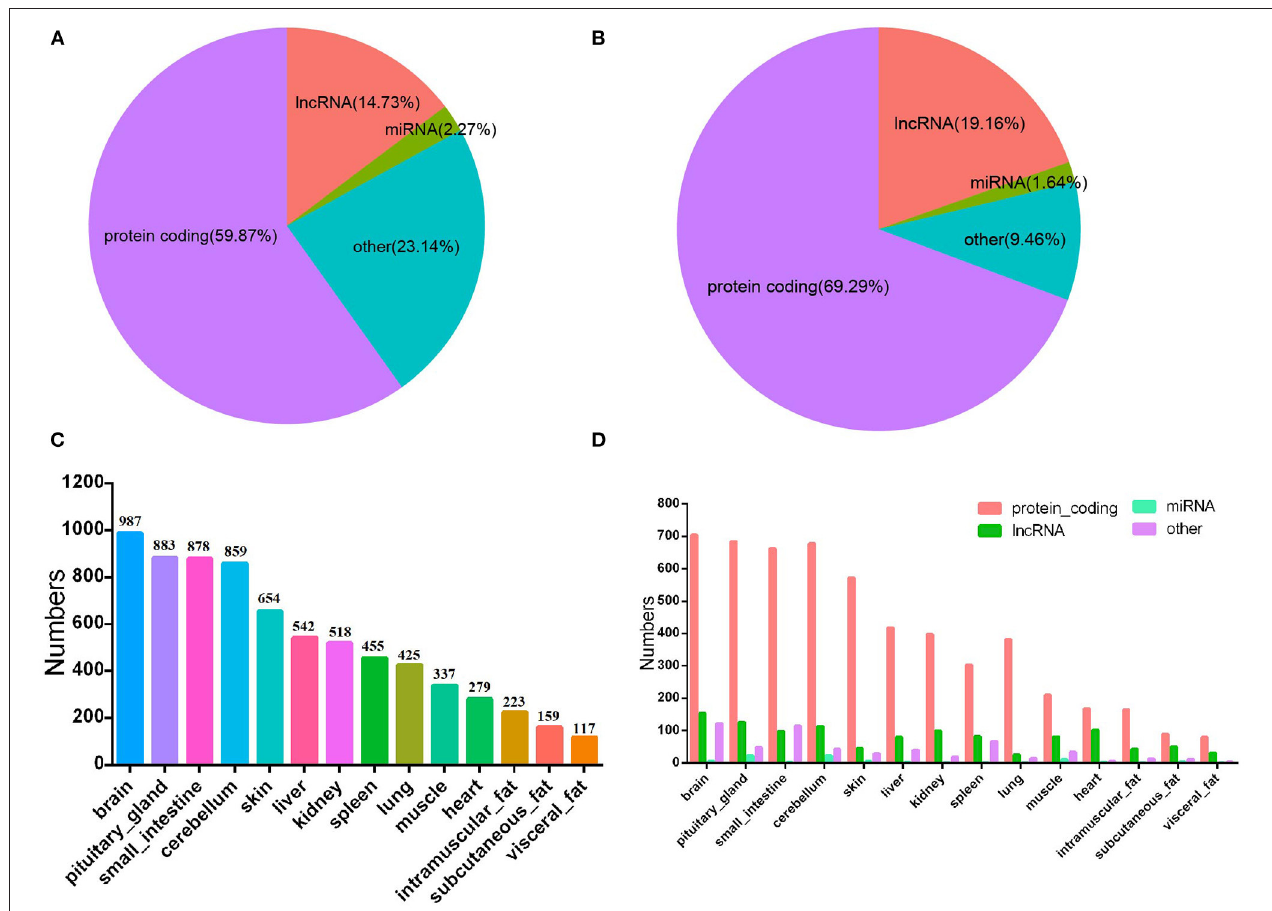
FIGURE 2 | Characteristics of bovine tissue-specific genes. (A) , The distribution of different kinds of RNA gene of bovine genome; (B) , bovine tissue-specific genes; (C) , the numbers of bovine tissue-specific genes; (D) , the number and rate of each kind of the bovine tissue-specific